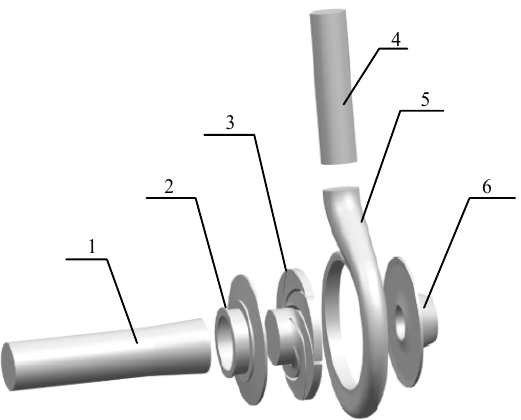
Figure 1. Pump model used in the simulation: 1. inlet pipe; 2. front chamber; 3. impeller; 4. outlet pipe; 5. volute; 6. rear chamber.